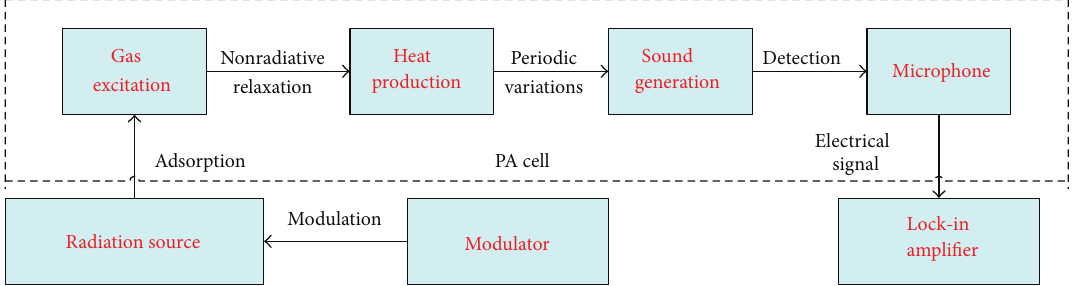
Figure 1: The principle of gas photoacoustic